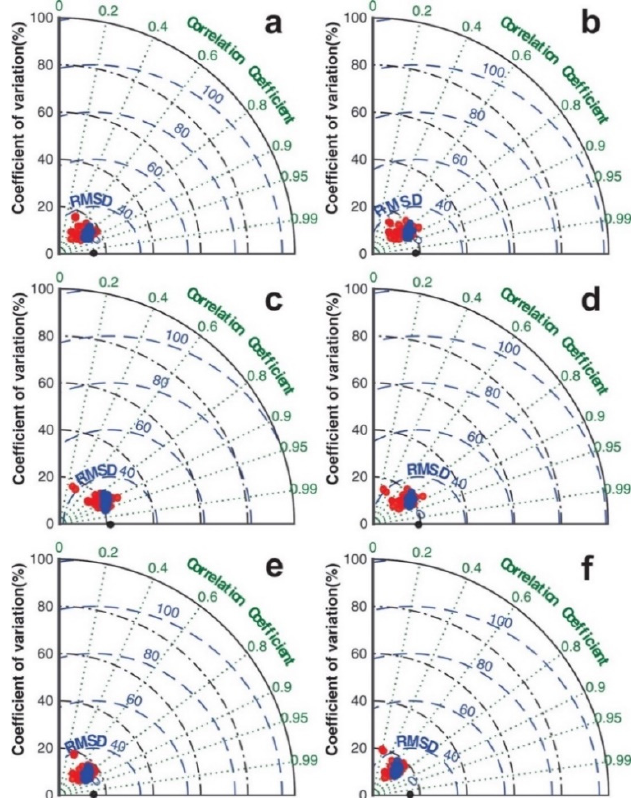
Figure 4. Taylor diagrams displaying a statistical comparison for evapotranspiration datasets (coefficient of variation (%), the root mean square deviation RMSD (%), and the correlation coefficient) between climate models with bias correction and climate models without bias correction (blue and red dots, respectively) for six basins controlled at the following stations: ( a ) Ramis, ( b ) Unocolla, ( c ) Ilave (located in Peru), and ( d ) Chuquiña, ( e ) Calacoto Maure ( f ) Calacoto Desaguadero (located in Bolivia), for the 1984–2014 period.